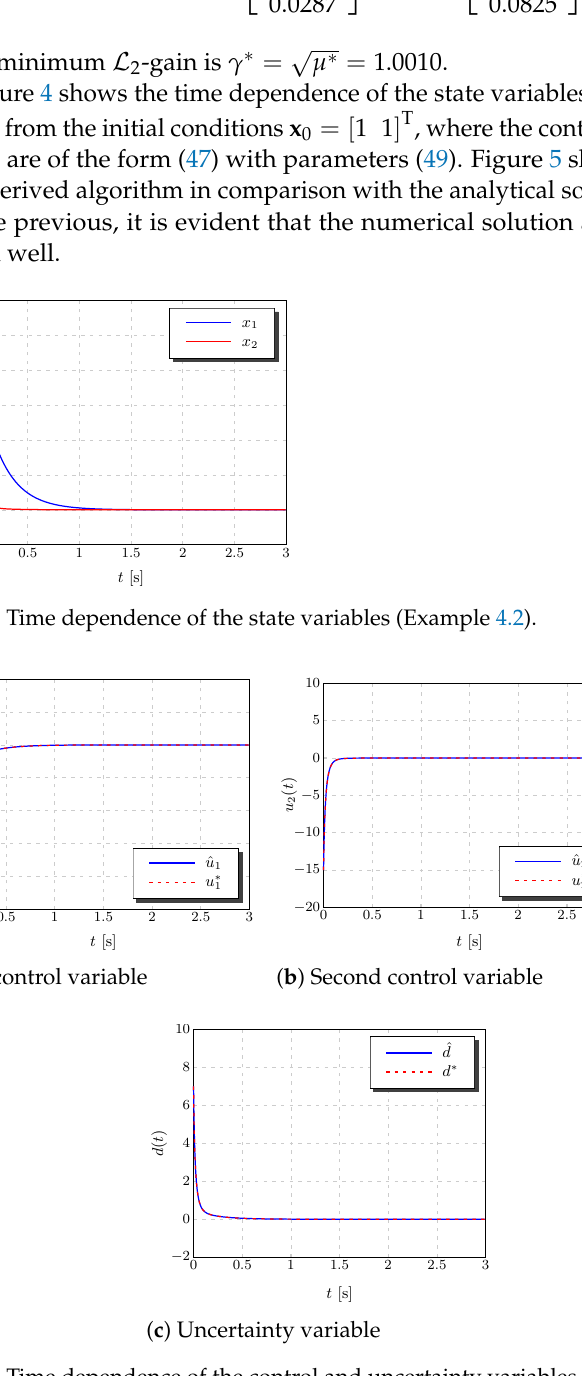
Figure 5. Time dependence of the control and uncertainty variables (Example